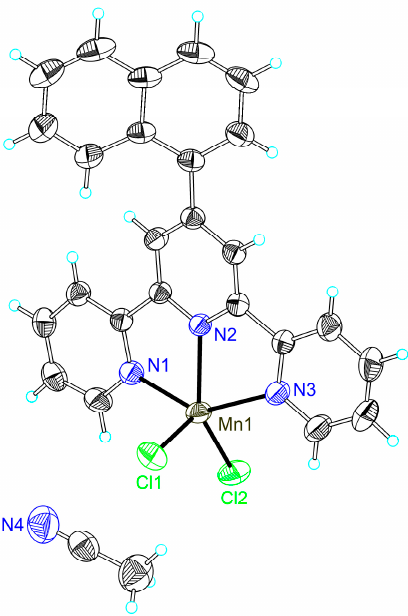
Figure 2. Thermal ellipsoid plot, drawn at the 50% probability level, of [MnCl 2 L 3 ]·CH 3 CN ( 3 ·CH 3 CN) with atomic numbering scheme. Selected bond lengths (Å) and angles (°): Mn(1)-N(2) 2.2028(13), Mn(1)-N(1) 2.2541(15), Mn(1)-N(3) 2.2595(15), Mn(1)-Cl(1) 2.3603(6), Mn(1)-Cl(2) 2.3558(5), N(2)-Mn(1)-N(1) 71.51(5), N(2)-Mn(1)-N(3) 71.71(5), N(1)-Mn(1)-N(3) 141.23(5), N(2)-Mn(1)-Cl(1) 108.08(4), N(1)-Mn(1)-Cl(1) 103.45(4), N(3)-Mn(1)-Cl(1) 99.15(4), N(2)-Mn(1)-Cl(2) 137.27(4), N(1)-Mn(1)-Cl(2) 100.29(4), N(3)-Mn(1)-Cl(2) 98.33(4), Cl(1)-Mn(1)-Cl(2) 114.57(2).